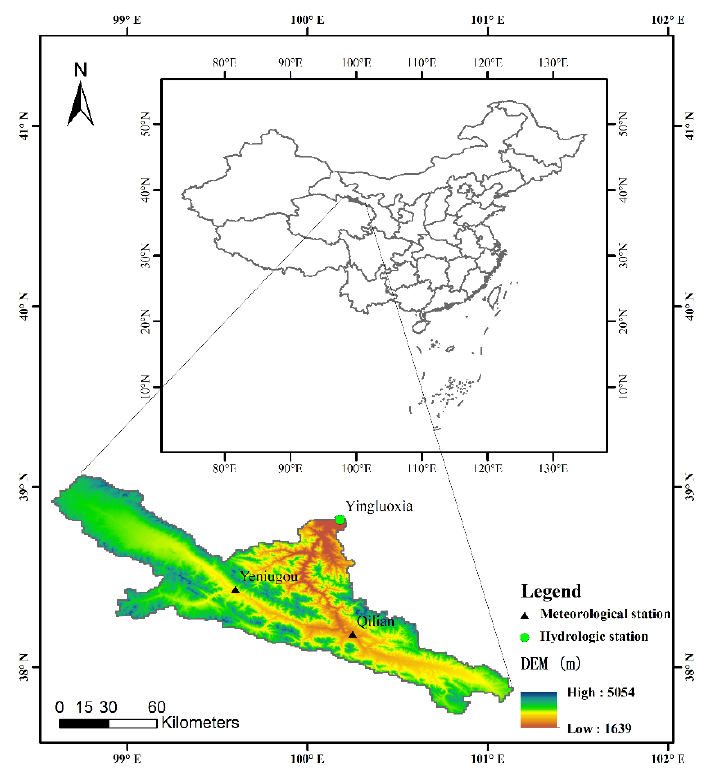
Figure 1. Location of the upper reach of the Heihe River basin in China. Table 1. Data used in the study and their sources and descriptions.